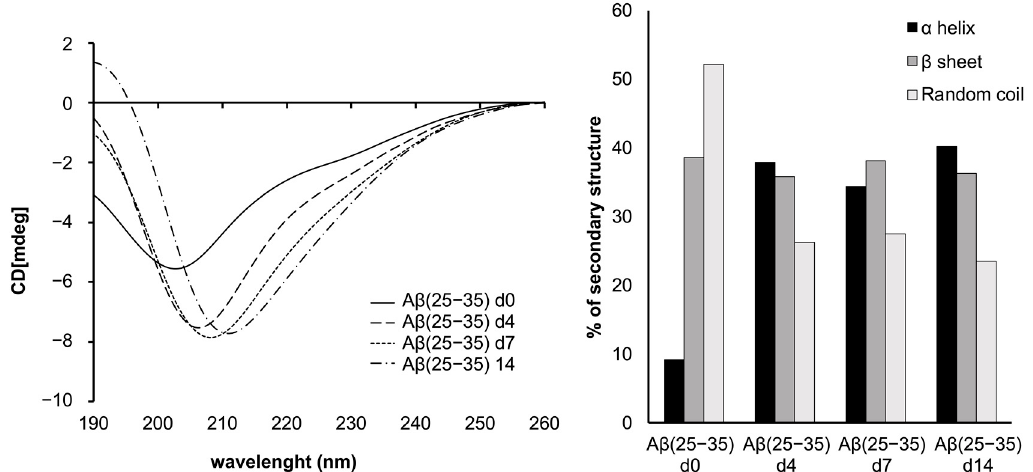
Figure 1. CD curves and secondary structure quantification performed with CONTIN algorithm of A β (25 − 35) peptide in SDS micelles at the time of the constitution of the system and after 4, 7 and 14 days.